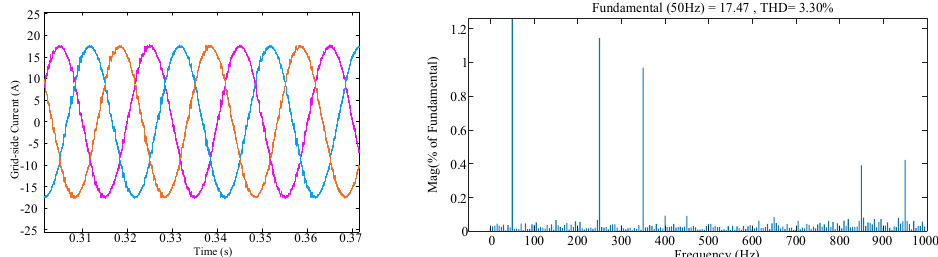
Figure 16. Simulation results of grid current with proposed method.